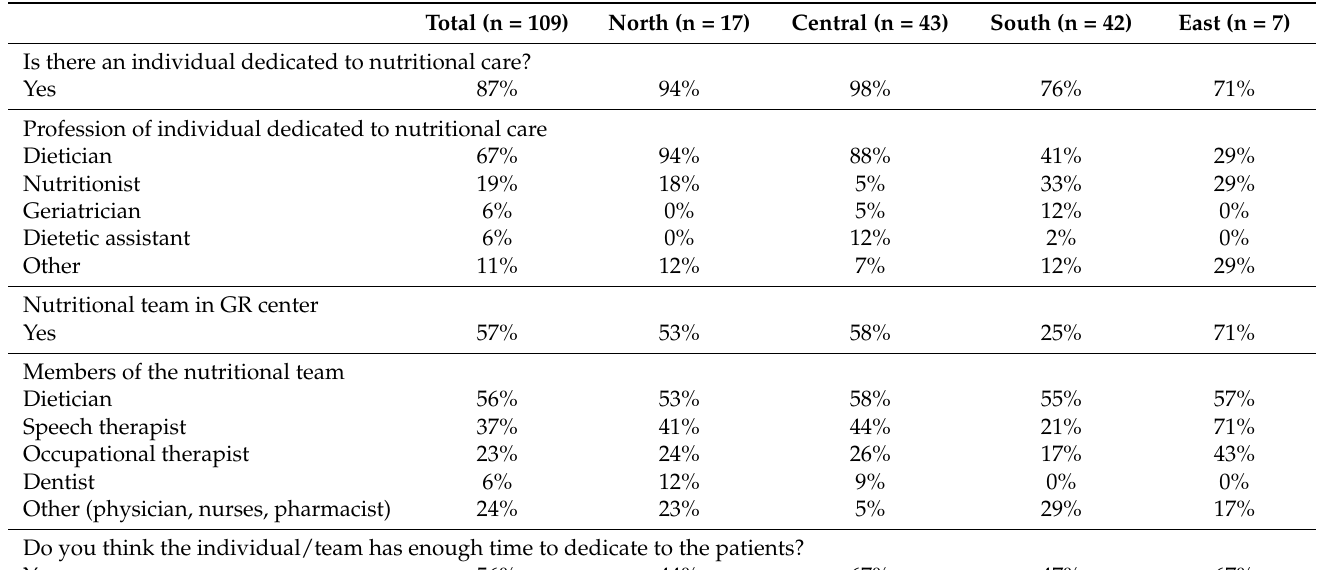
Table 2. Dedicated nutritional care in GR centers.